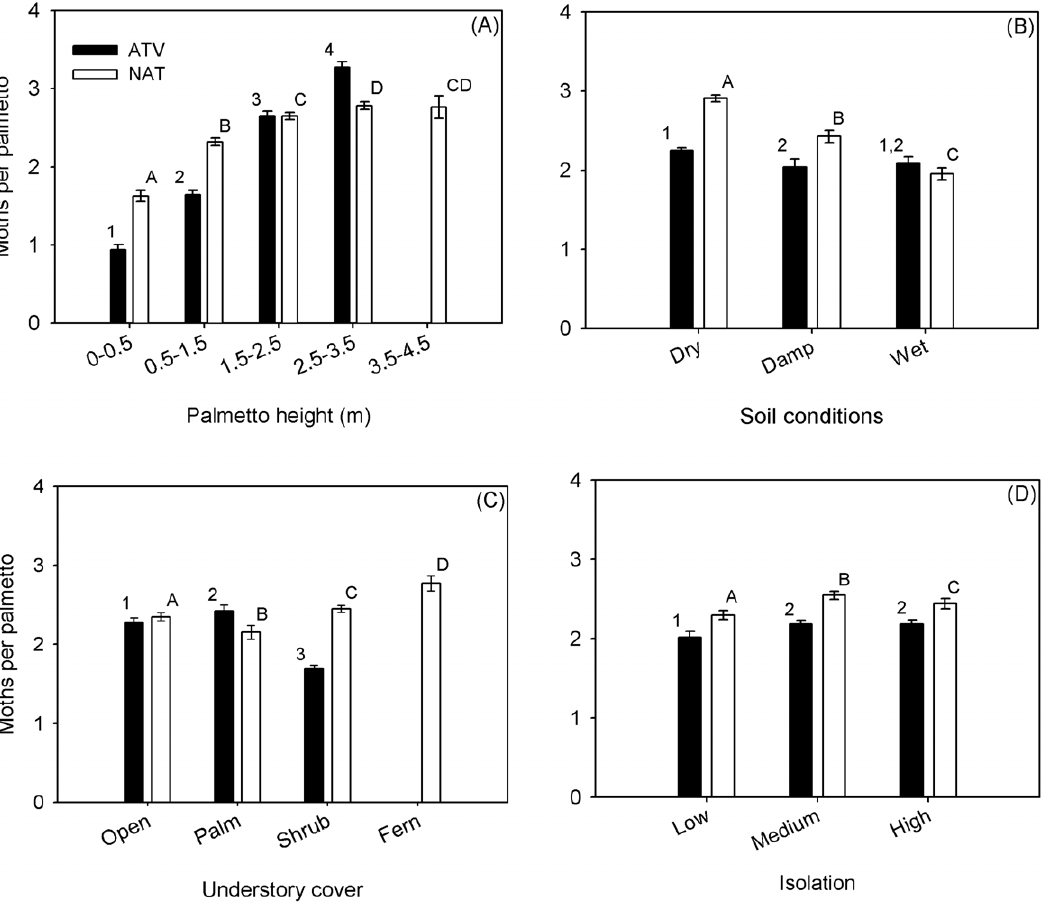
Figure 2. The influence of (A) palmetto height, (B) soil wetness (dry, damp and wet),(C) understory cover (open, other palmettos, shrubs or ferns), and (D) isolation (low, medium, high) on the mean number of PLS pupae per palmetto ( ± SE ). Separate Poisson- regression analyses were performed for ATV (open bars) and NAT (filled bars) and differences ( P , 0.05) among treatment means were denoted by different numbers (ATV) and letters (NAT).